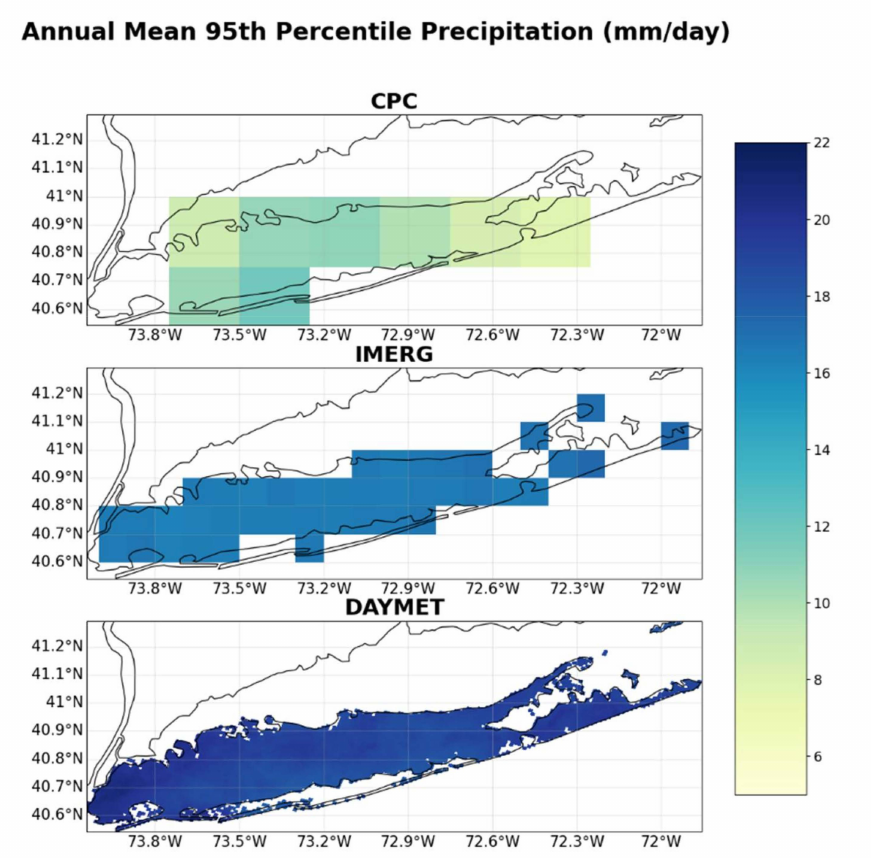
Figure 2. Annual average 95th-percentile precipitation (mm/day) for the common time period (2001–2020) for ( top ) CPC, ( middle ) IMERG, and ( bottom ) DAYMET. Next, the time evolution of 95th-percentile precipitation averaged over all grid